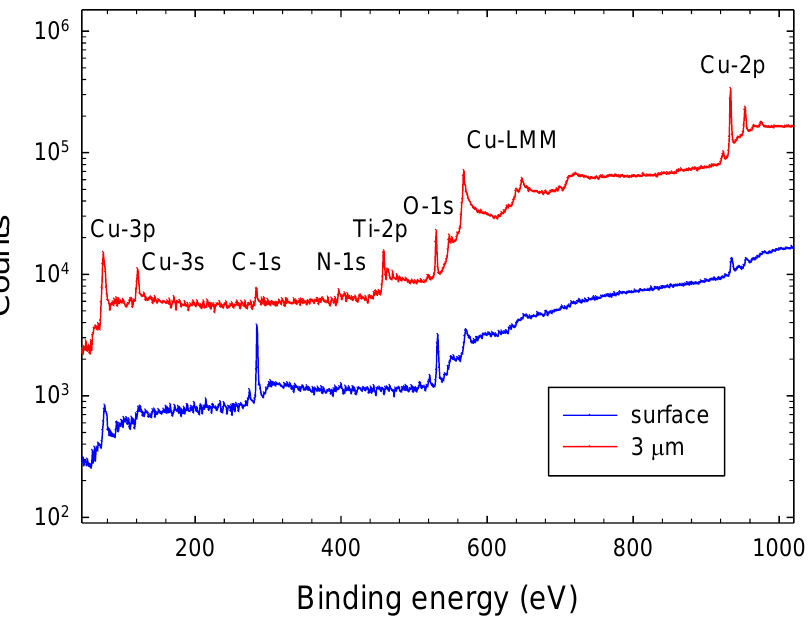
Figure 2. Full-scale (40 eV to 1020 eV) XPS spectrum of a deposited Ti x -Cu y N z thin film of the as-deposited film (surface) and at a film depth of 3 µ